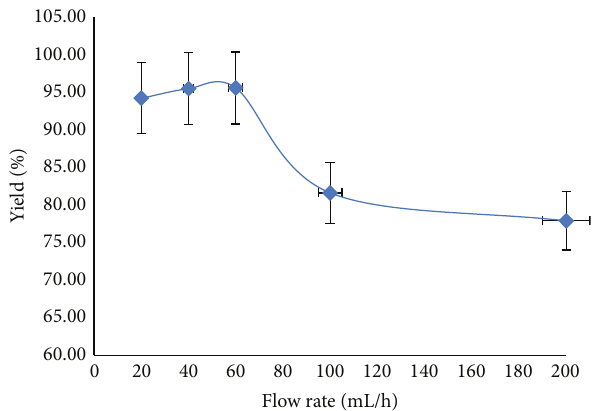
Figure 4: Effect of reactants flow rate on percentage biodiesel yield.